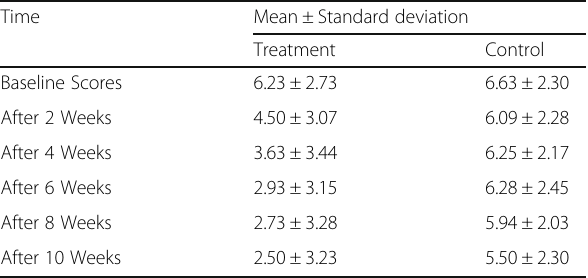
Table 3 Mean visual analogue scale scores of the participants in each group across 10 weeks